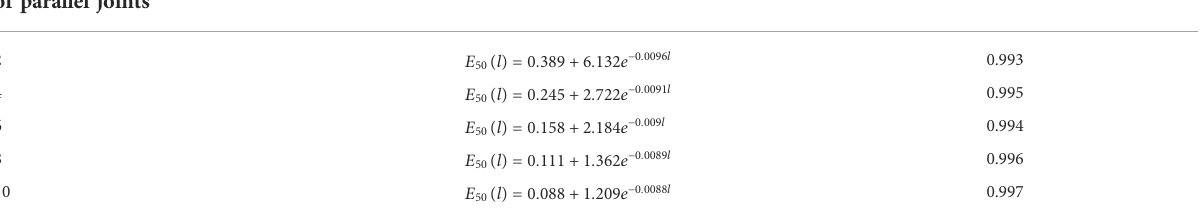
TABLE 7 Fitting relationship of the secant modulus. Number of parallel